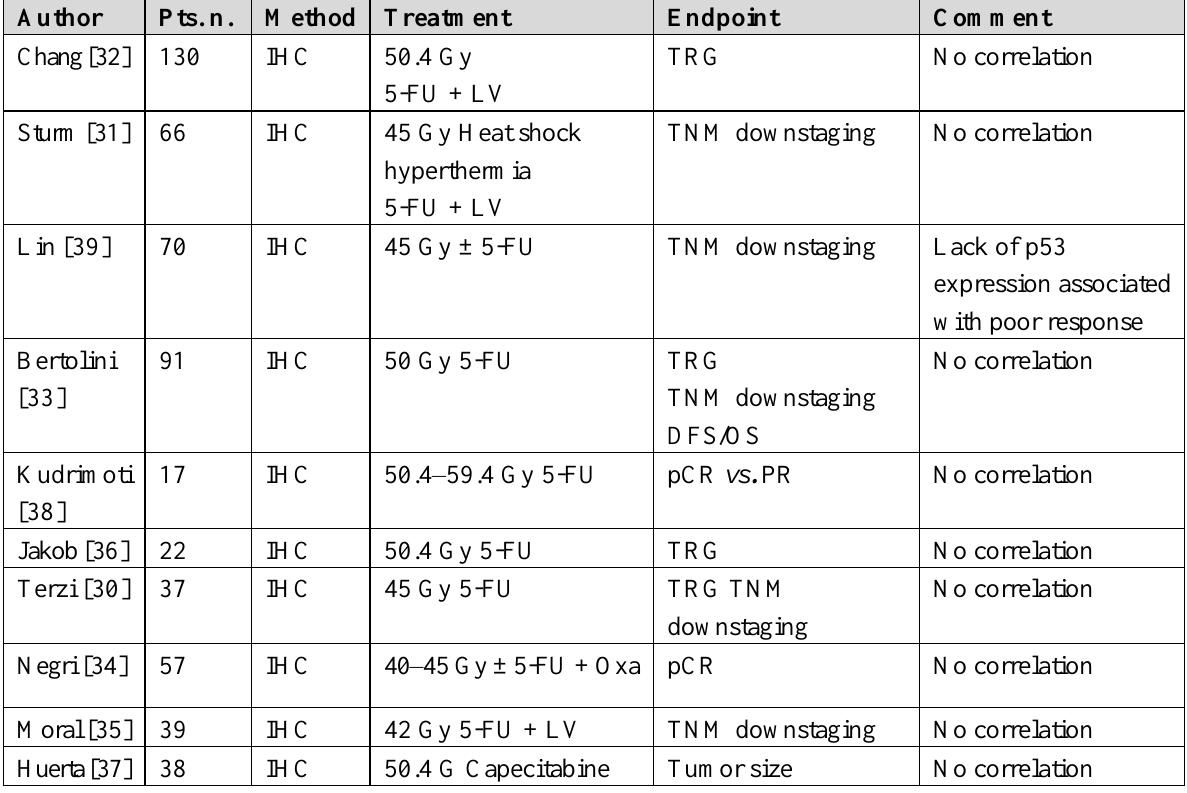
Table 1. p53 expression and prediction of response to neoadjuvant radiochemotherapy in locally advanced rectal cancer